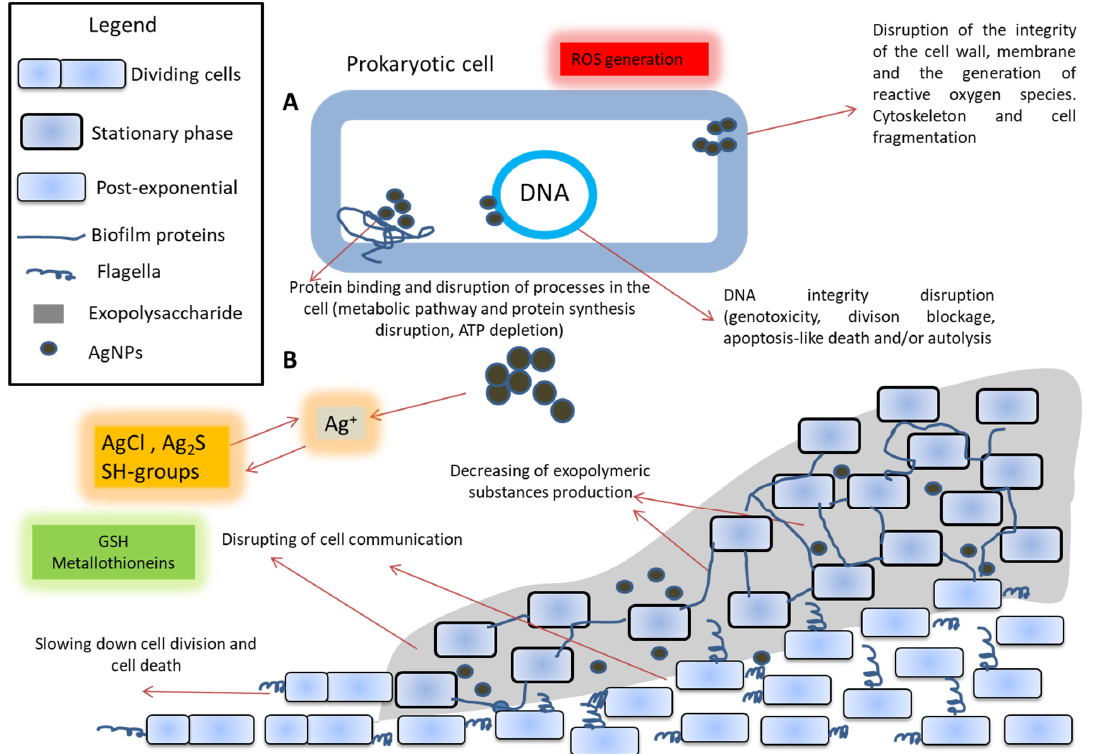
Figure 2. The presumed effect of silver nanoparticles (AgNPs) on prokaryotic cells ( A ) and biofilms ( B ). Silver ions can be released from silver nanoparticles in the environment. These ions can react with chlorides to form AgCl, with sulfur to form Ag 2 S, with the SH groups of glutathione or metallothionein. Silver nanoparticles act on the cell, disrupting the processes of regulation, protein synthesis, ATP depletion, and damaging the cell wall. Additionally, an increased level of free radicals and a disruption of the integrity of DNA, division, blockage, apoptosis-like death and/or autolysis are observed. All this results in a violation of the structure and the synthesis of the components of biofilms. Additionally, it leads to disrupt intercellular signaling and direct cell death in the biofilm